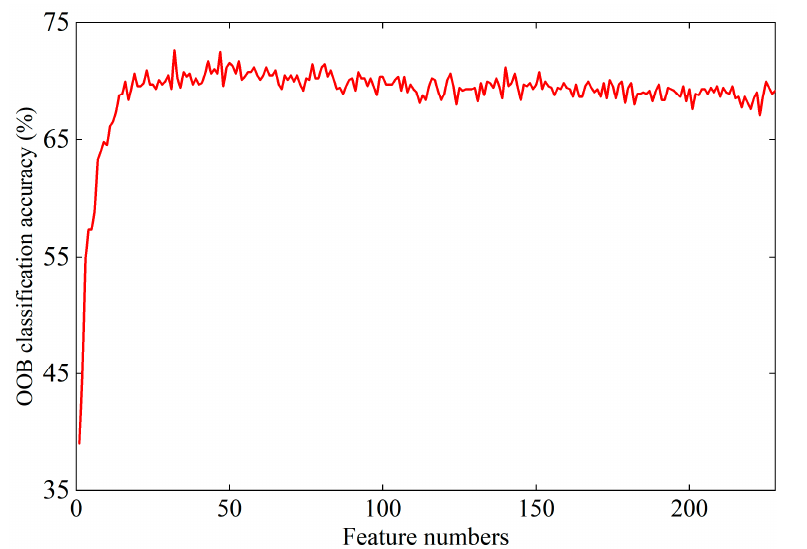
Figure 14. RF OOB classification accuracy with different numbers of S2 features.